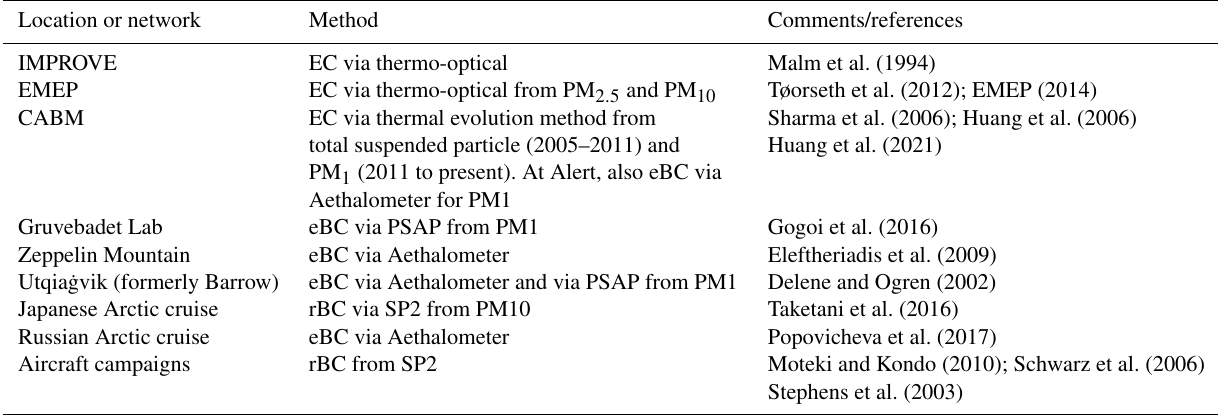
Table B1. Information about Arctic BC measurements used for model evaluation.